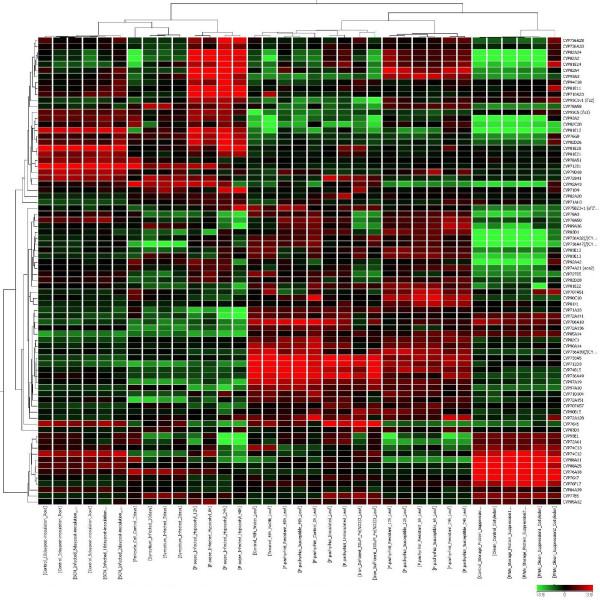
Expression pattern of soybean P450 genes under stress treatments according to the analysis of Affymetrix soybean microarray dataset. The color scale indicates the degree of expression (green: low expression; red: high expression). Heat map was created using GeneSpring 10X.